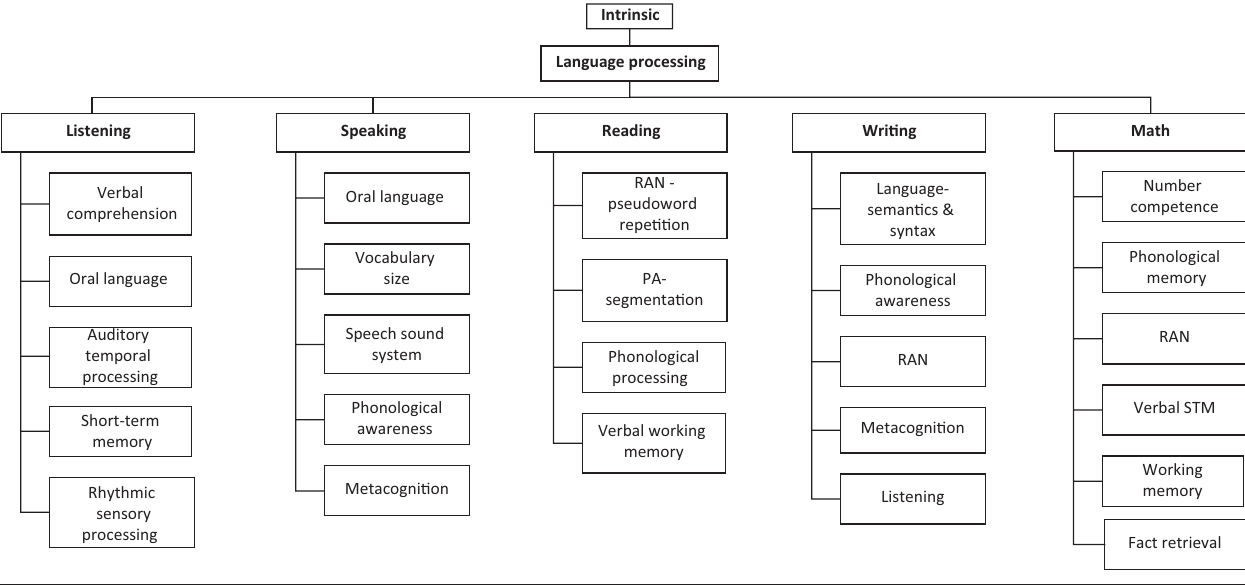
FIGURE 3: Intrinsic indicators of language-based learning